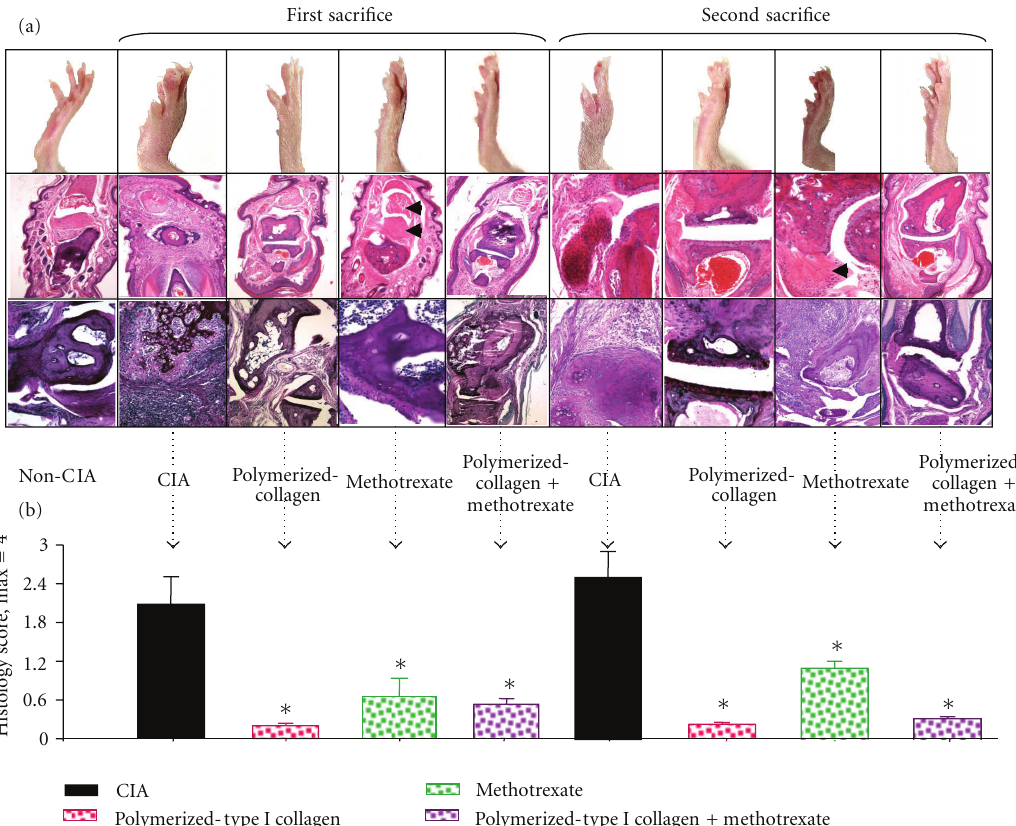
Figure 2: Preventive e ff ect of polymerized-type I collagen on the histological damage in CIA mice. (a) Representative section of joint histopathology is shown. Upper panel: hematoxylin and eosin stained and lower panel: PAS stained; magnification: 10x. Arrow heads point out nodules. (b) Pathology scores of each group were calculated and expressed as mean ± SEM ( n = 6). ∗ P < 0 . 05.